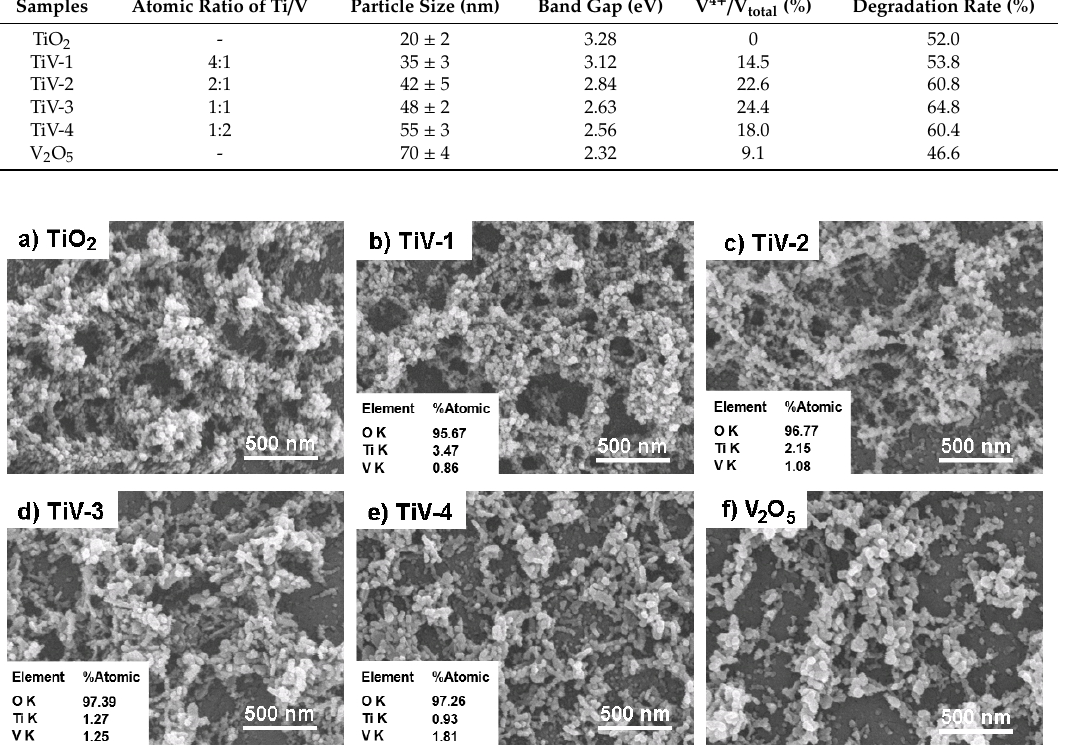
Figure 1. Surface morphologies of ( a ) TiO 2 , ( b – e ) TiV1–4, and ( f ) V 2 O 5 samples.